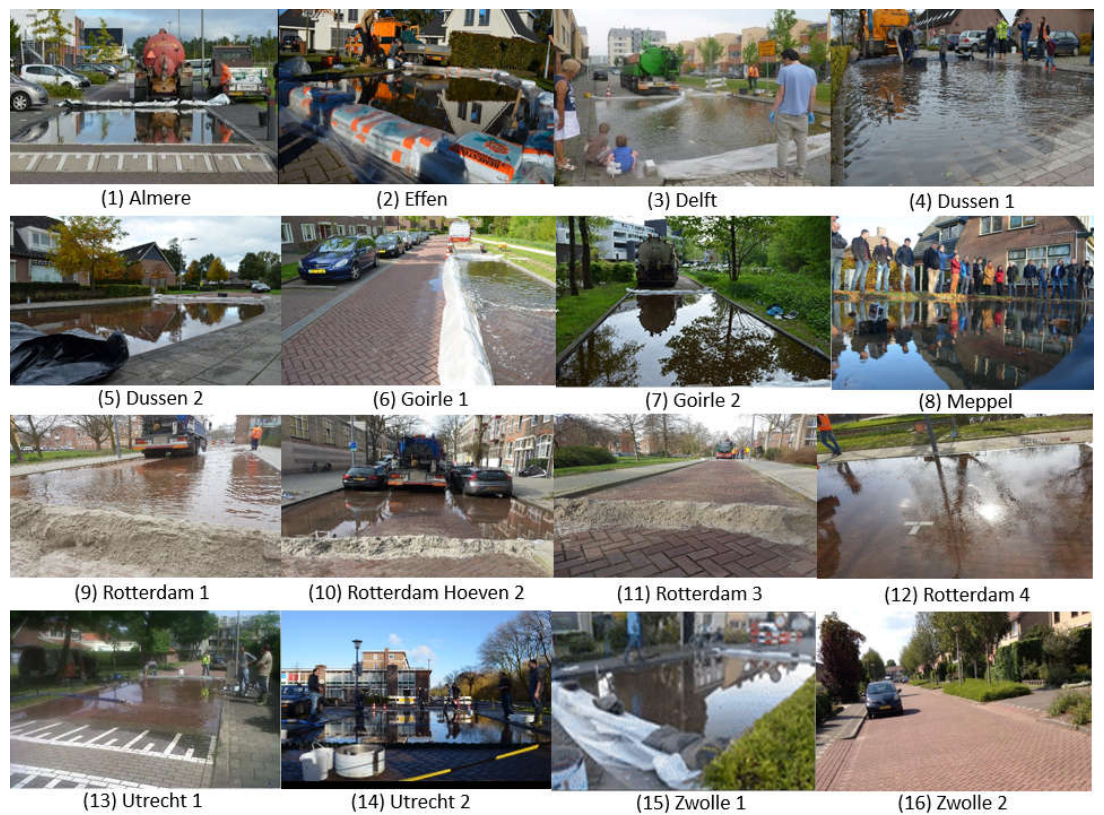
Figure 7. All 16 pavements tested using FSIT and the location numbers in Figure 3.